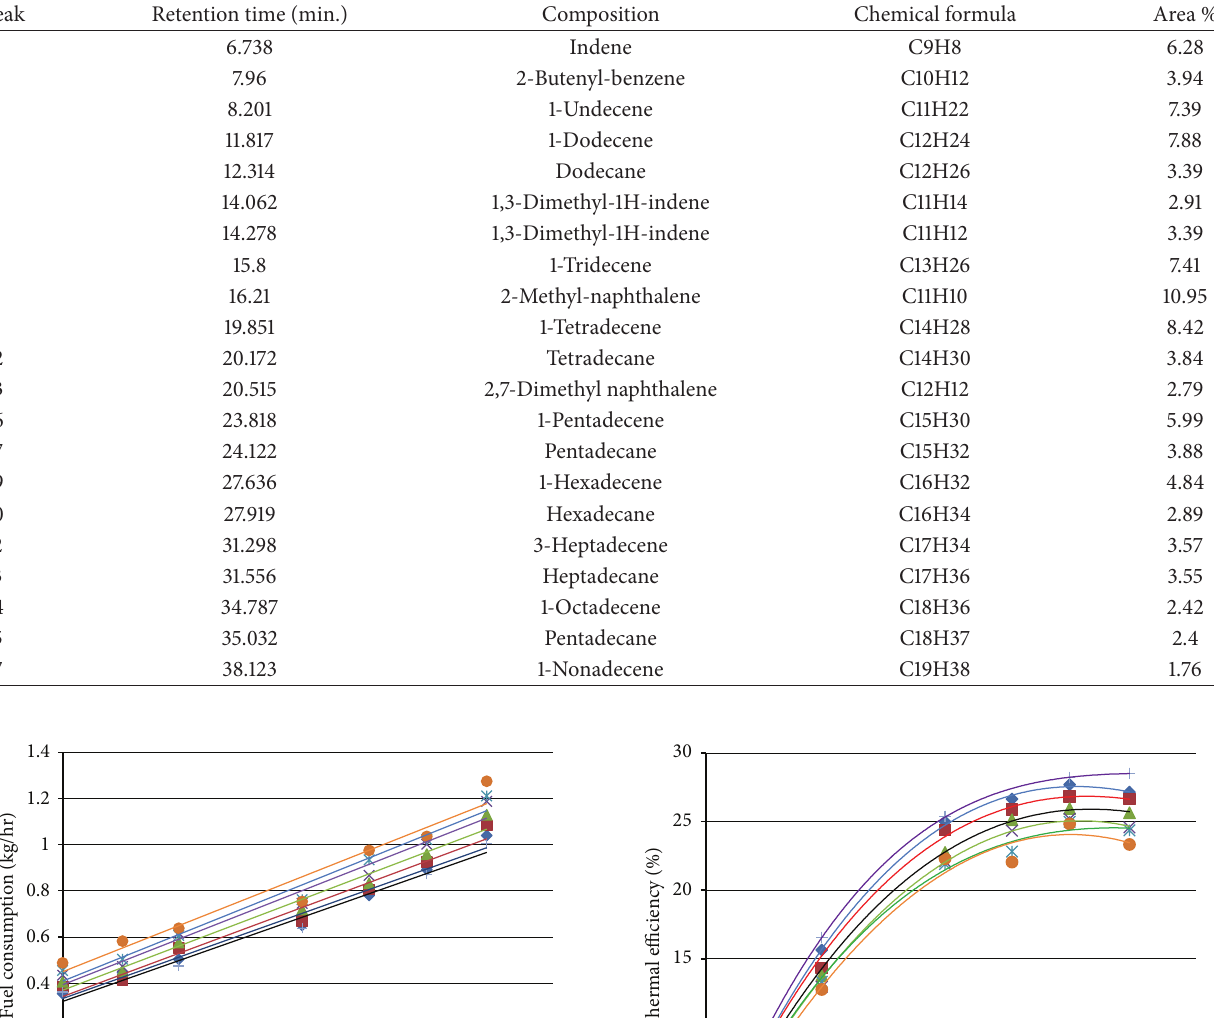
Table 3: Chemical composition of plastic oil sample.